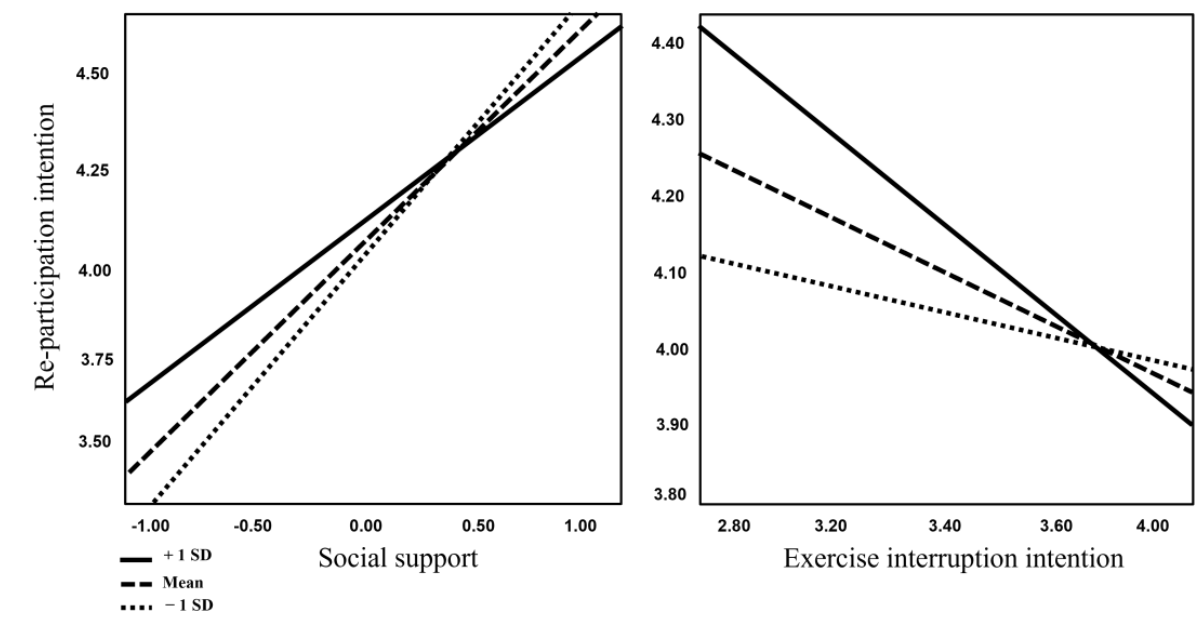
Figure 2. Interaction effects graph.